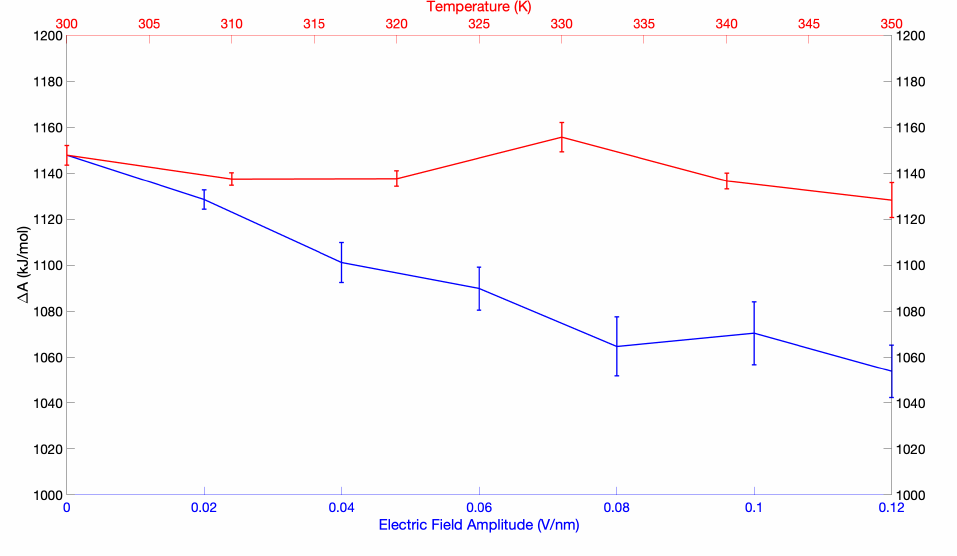
Figure 4. Comparison between the effect of electric field and temperature on Cys 35 in